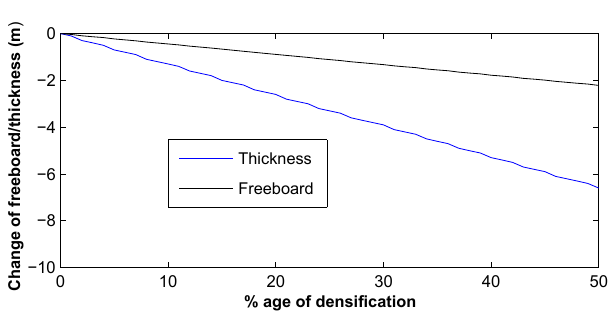
Figure A1. Variation of thickness (blue line) and freeboard (black line) as a function of the percentage of firn densification for a 450m thick iceberg .